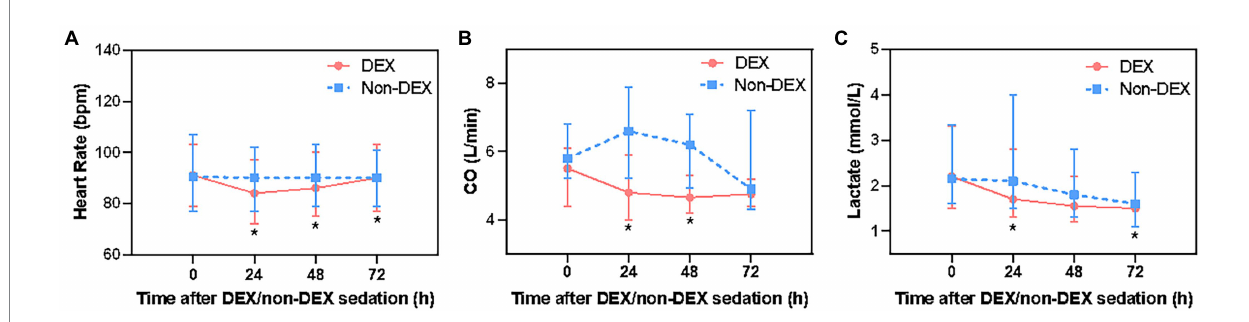
FIGURE 3 The effect of DEX/non-DEX administration on other hemodynamic parameters in patients with septic shock and mechanical ventilation. (A) Heart rate. (B) CO. (C) Lactate level. *Statistically significant after Bonferroni correction ( p <